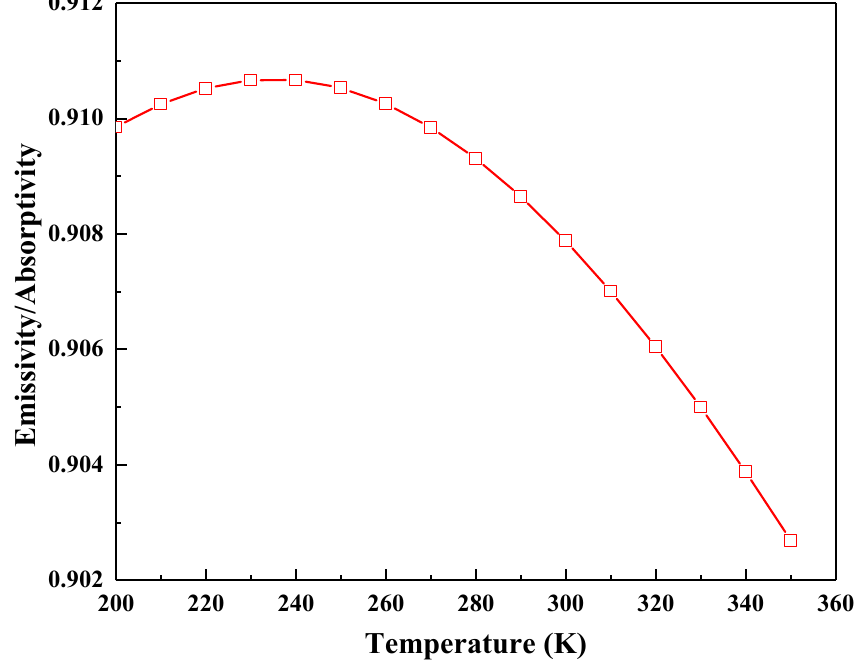
Figure 7. The variation of the emissivity/absorptivity with radiative plate temperature.